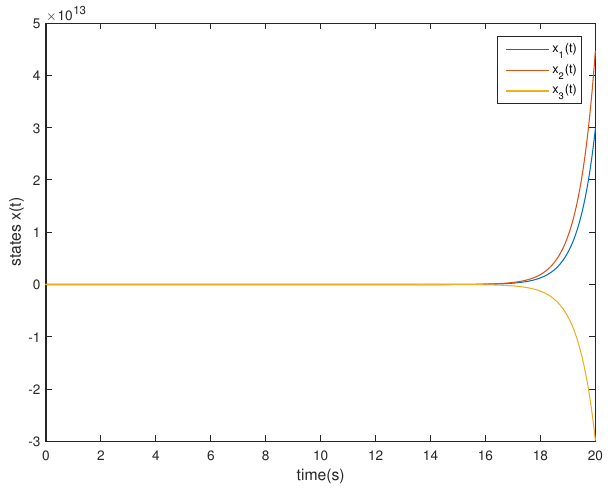
Figure 2. States responses of singular FOS in Example 2.